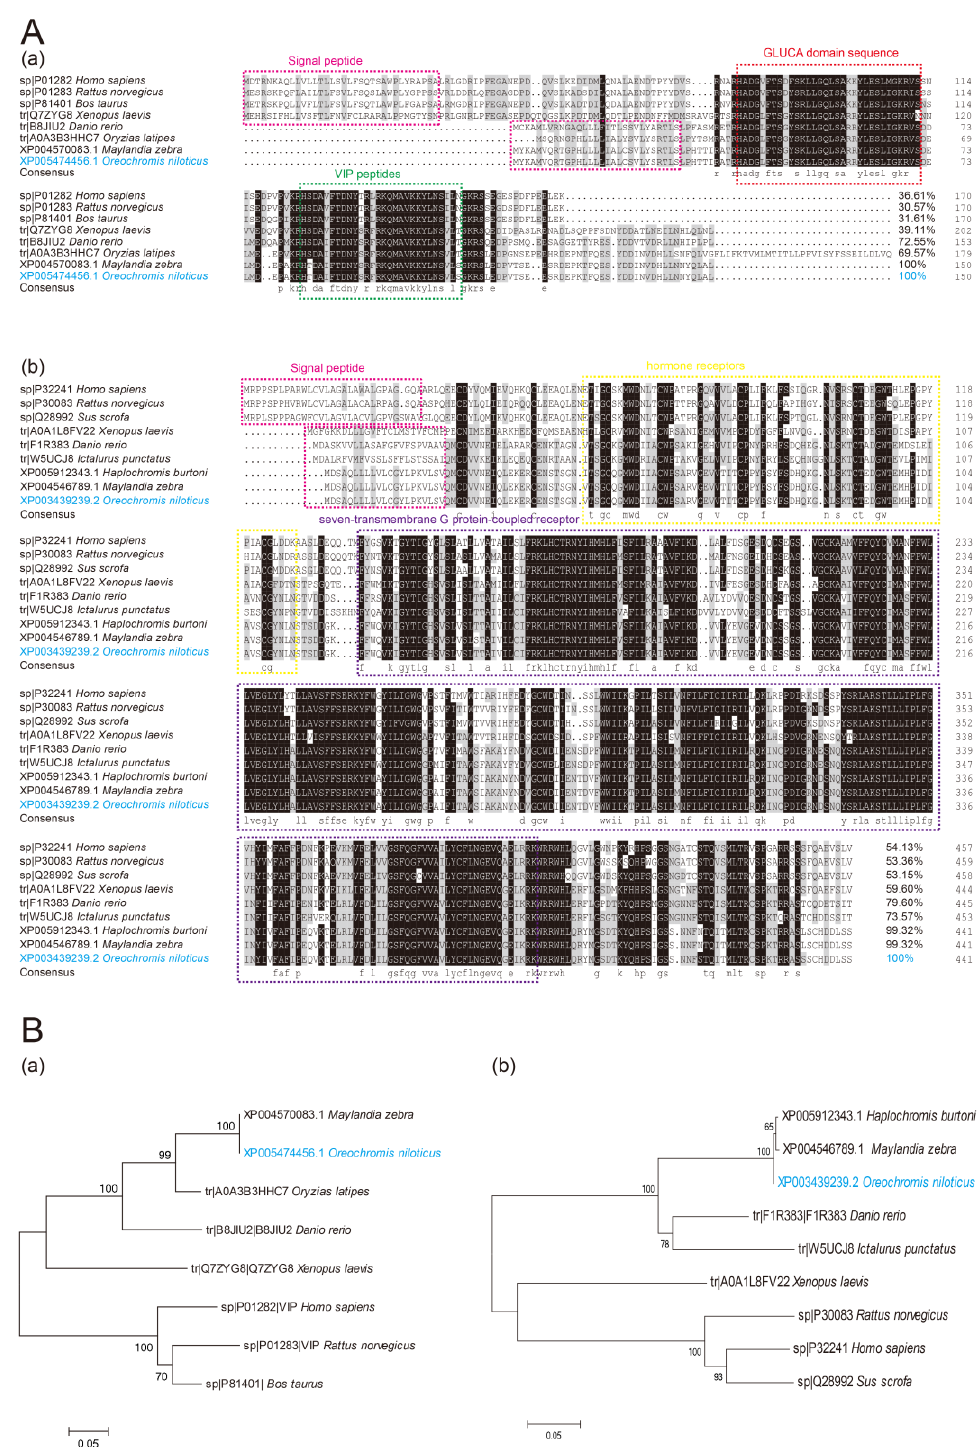
Figure 1. ( A ) The multiple alignments sequence of VIP ( a ) and VIPR1 ( b ) from several species. The signal peptide domain was marked in the pink dotted box. The GLUCA domain sequence and VIP peptides are marked in red and green dotted boxes, and the hormone receptors and seven- transmembrane G protein-coupled receptors are marked in yellow and purple dotted boxes. ( B ) The phylogenetic trees of VIP and VIPR1 were created using the MEGA 6.0 software. On-VIP ( a ) and On-VIPR1 ( b ) are marked in blue.